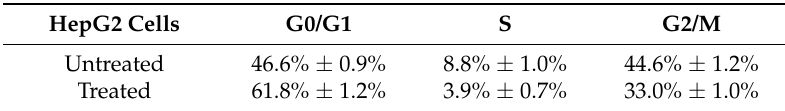
Table 2. Cell cycle evaluation. The cell percentages in G0/G1, S, and G2/M phases are reported for HepG2 cells before and after treatment with 137 µ g/mL of PECS at 48 h.